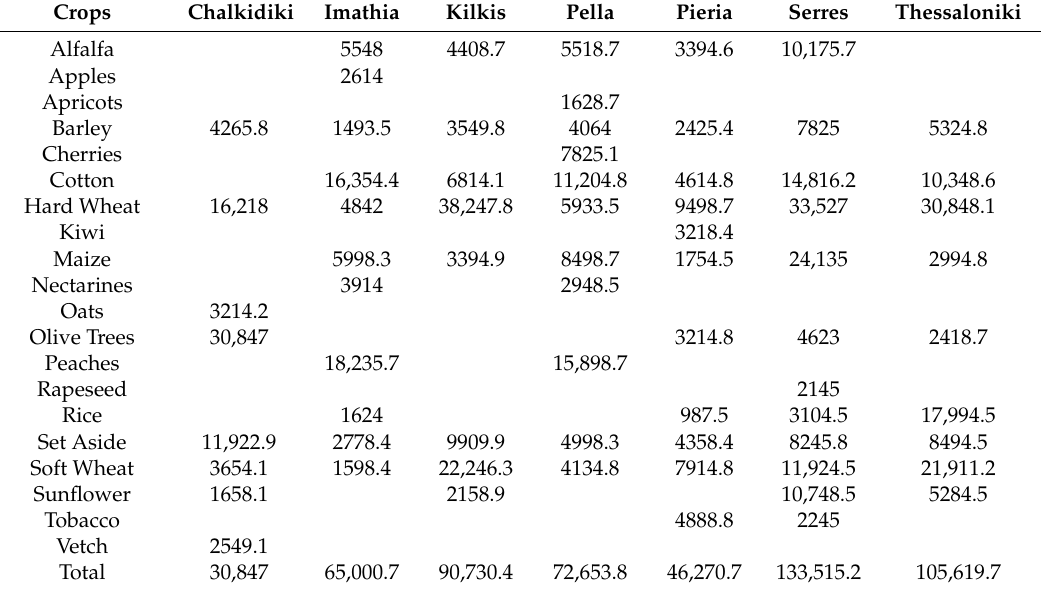
Table 1. Crop plans of the agro-energy regions of the